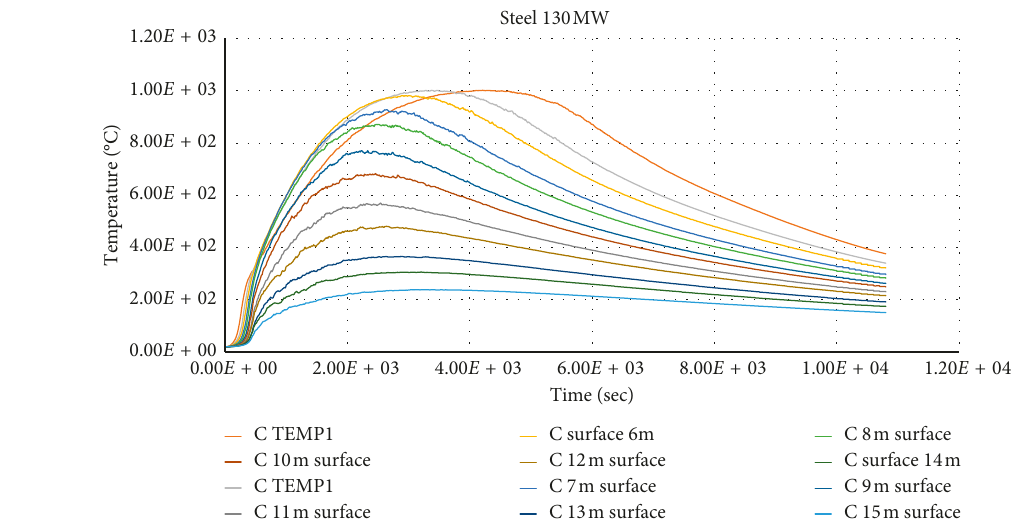
Figure 4: 130MW steel bridges temperature-time